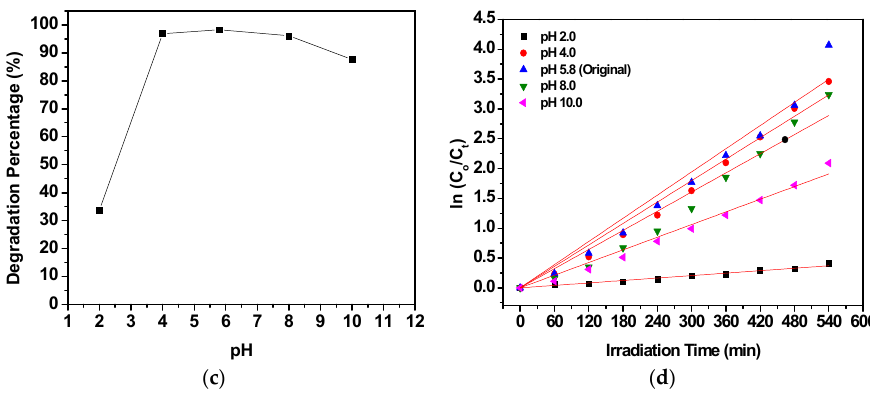
Figure 8. ( a , b ) The effect of the quantity of films and ( c , d ) the effect of initial pHs on the degradation percentage and kinetics of the degradation of MO by the PZ ‐ 17 film photocatalyst. Table 1. Kinetic data and the amount of methyl orange (MO) degraded at different quantity of film by the PZ ‐ 17 film photocatalyst.